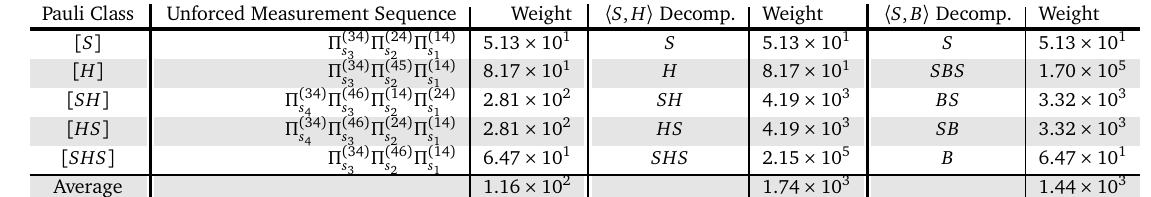
Table 22: Minimal difficulty weight measurement sequences for each Pauli coset of single-qubit Clifford gates when using Majorana-Pauli tracking methods. For comparison, we also present the corresponding realization of the gates formed by using the generating gate sets 〈 S , H 〉 and 〈 S , B 〉